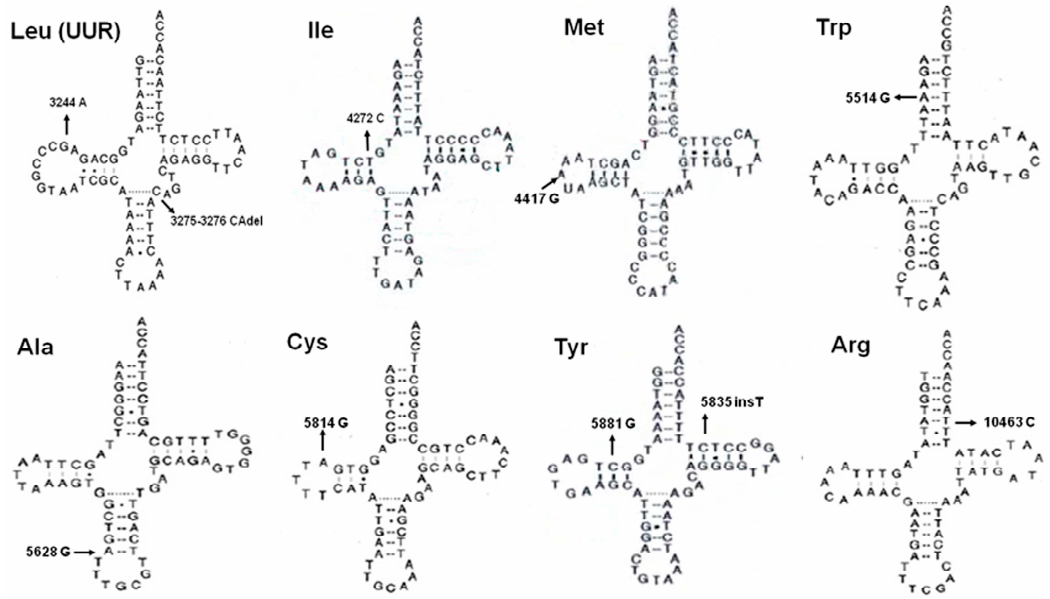
Figure 1. Potential pathogenic tRNA variations in PTC Schematic structures of eight mitochondrial tRNAs are shown. Arrows point out the position of tRNA variation.